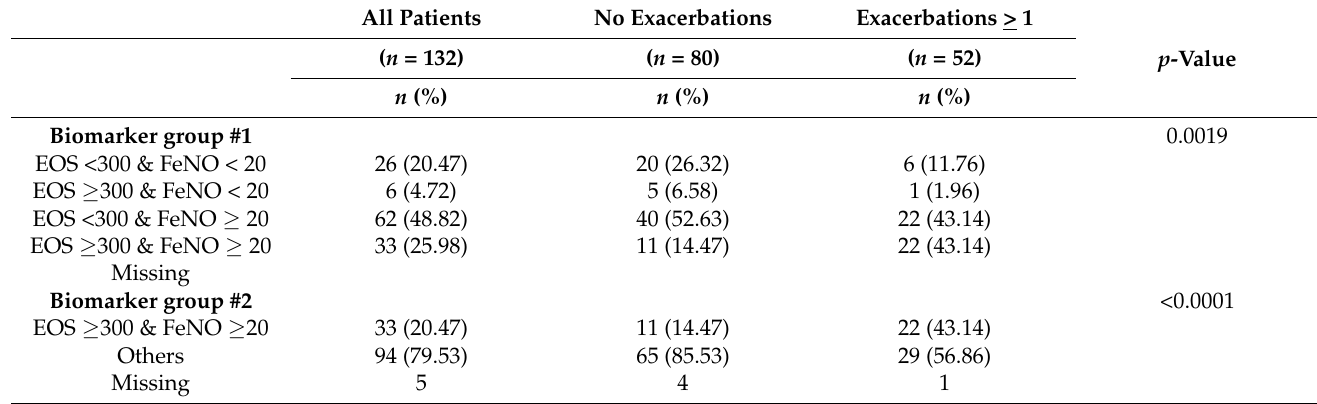
Table 4. The relationships between exacerbation and the biomarker group. All Patients